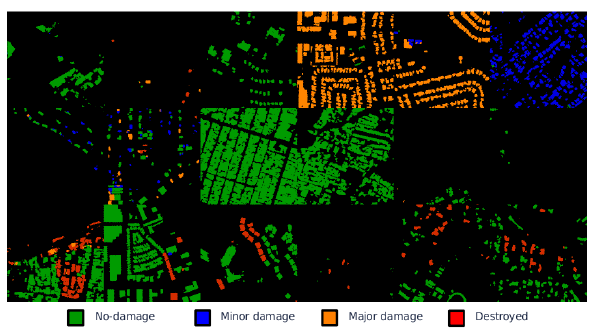
Figure 7. Results with siamese